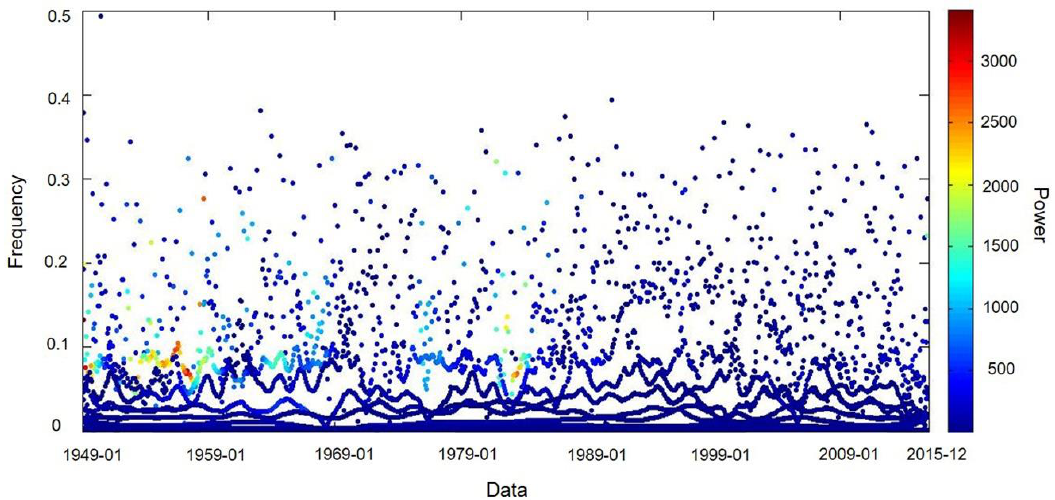
Figure 15. The Hilbert spectrum for the 67 m series of HHS.